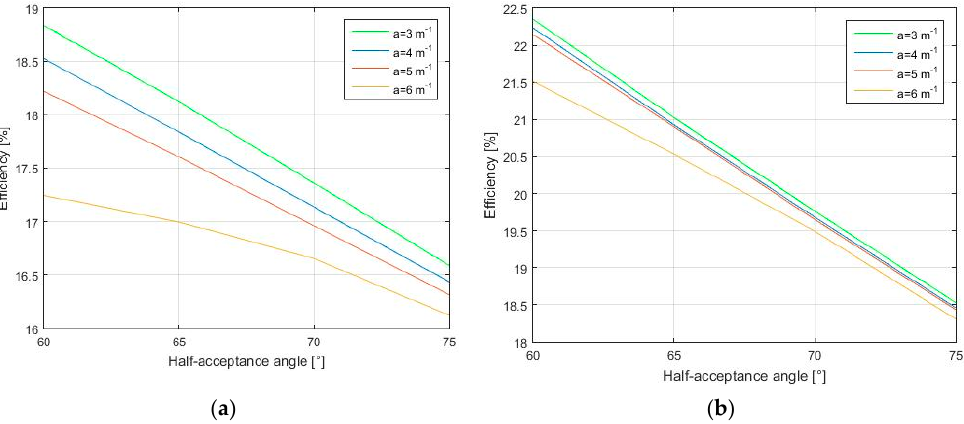
Figure 18. Maximum efficiency of the whole system for different half-acceptance angles and parabola coefficients: ( a ) covered CPC system; ( b ) uncovered CPC system.